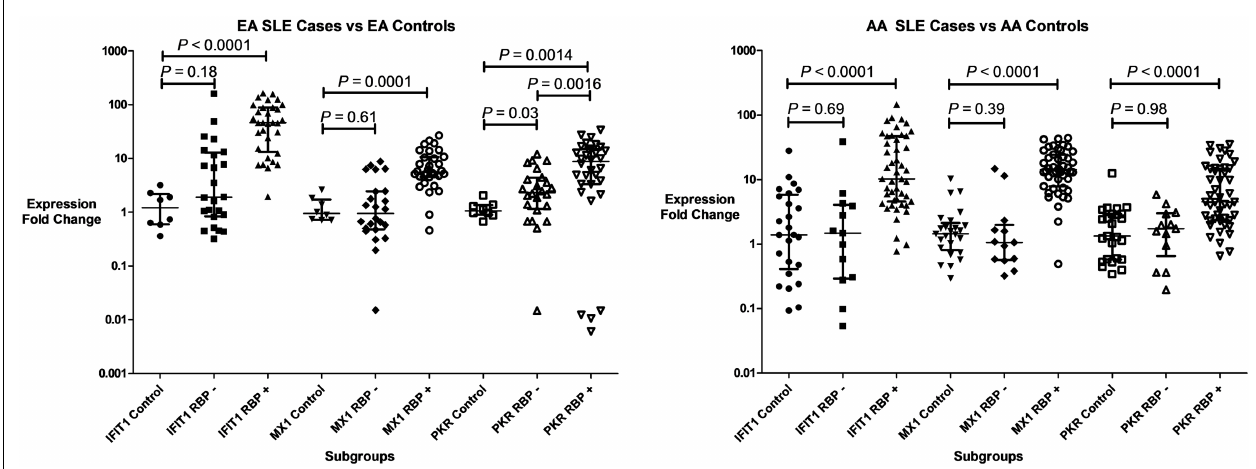
who lack those antibodies (RBP − ). Central tendency shown is a median, with error bars representing the interquartile range. P values generated by Mann–Whitney U test.